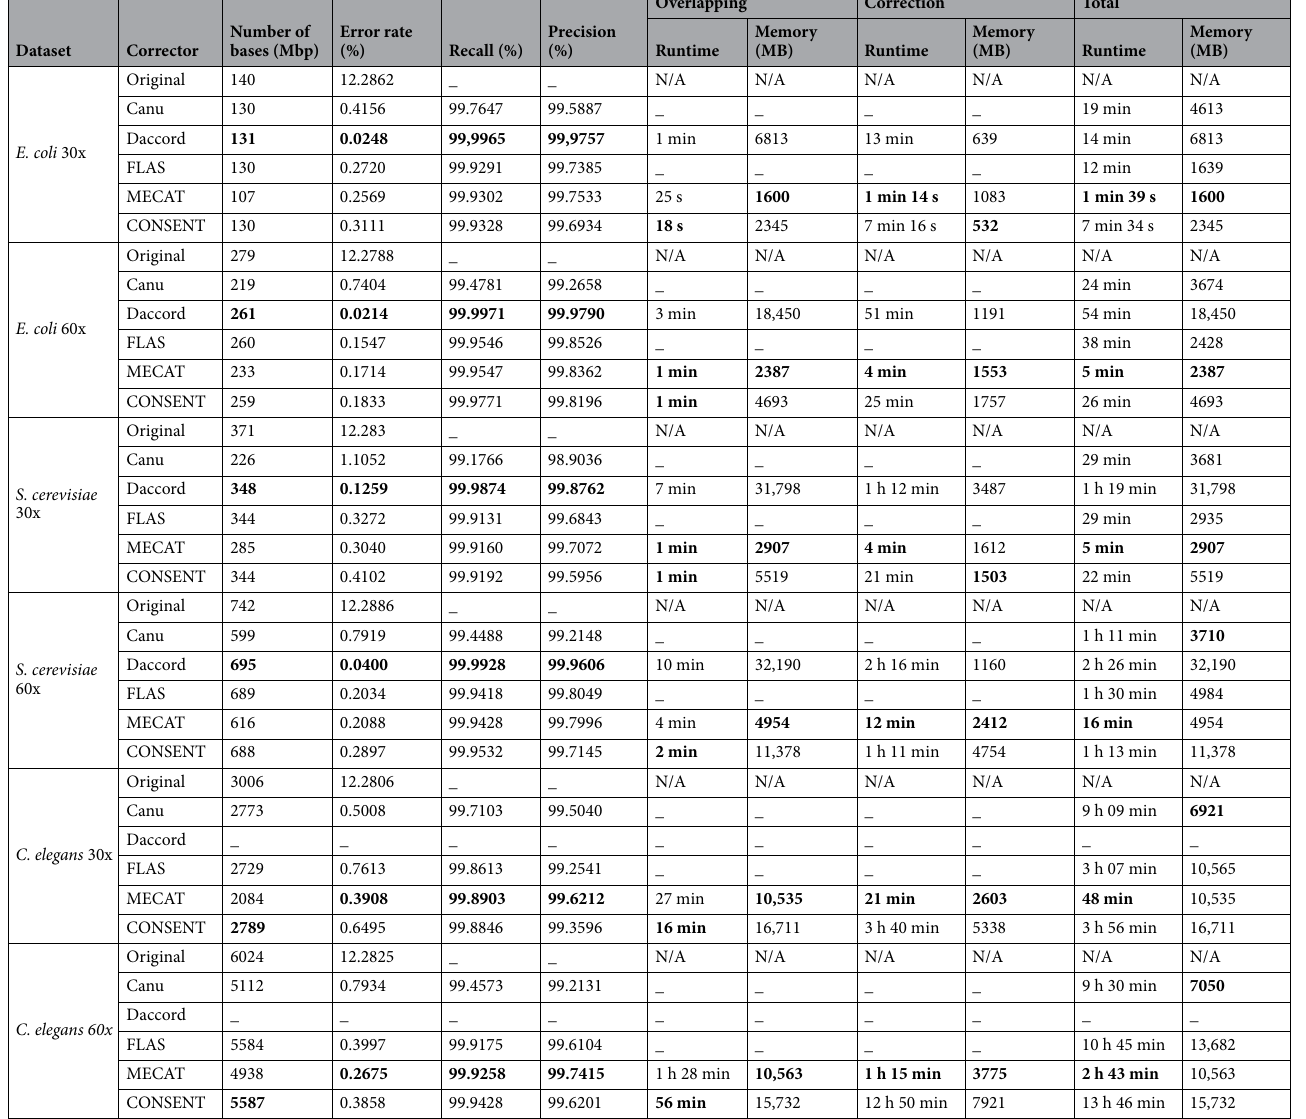
Table 1. Metrics output by ELECTOR on the simulated PacBio datasets. Daccord results are missing for the two C. elegans datasets, as DALIGNER failed to perform alignment, reporting an error upon start, even when ran on a cluster node with 28 2.4 GHz cores and 128 GB of RAM. Recall and precision are not reported for original reads, since they cannot be computed from uncorrected reads. Best results for each metric is highlighted in